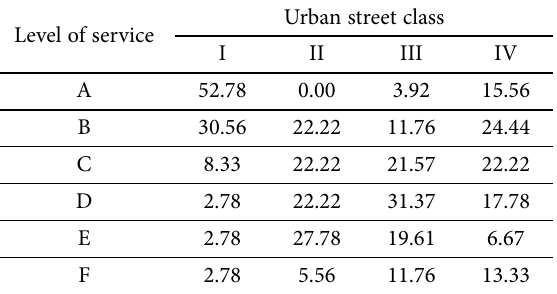
Table 5. Comparison of percent FFS values for each LOS categories as obtained using k -medoid clustering method Level of service